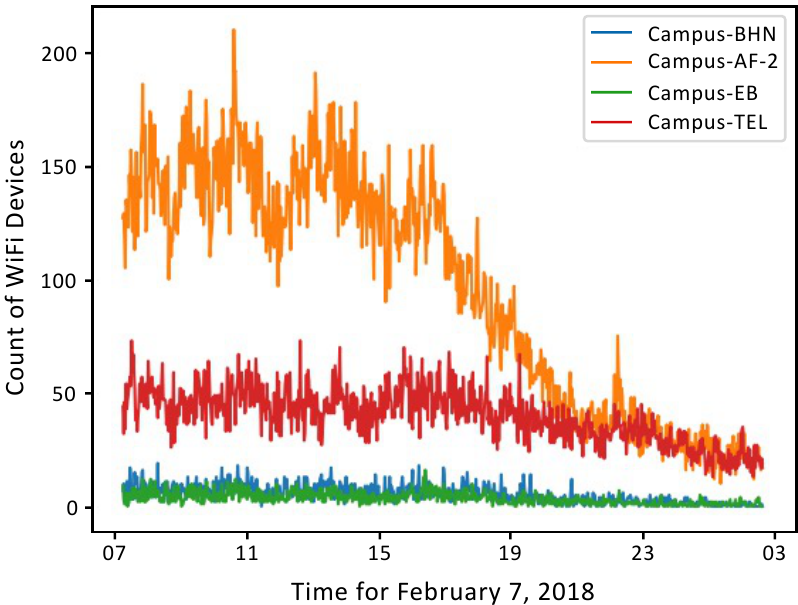
Figure 15. WiFi density for a single day at each